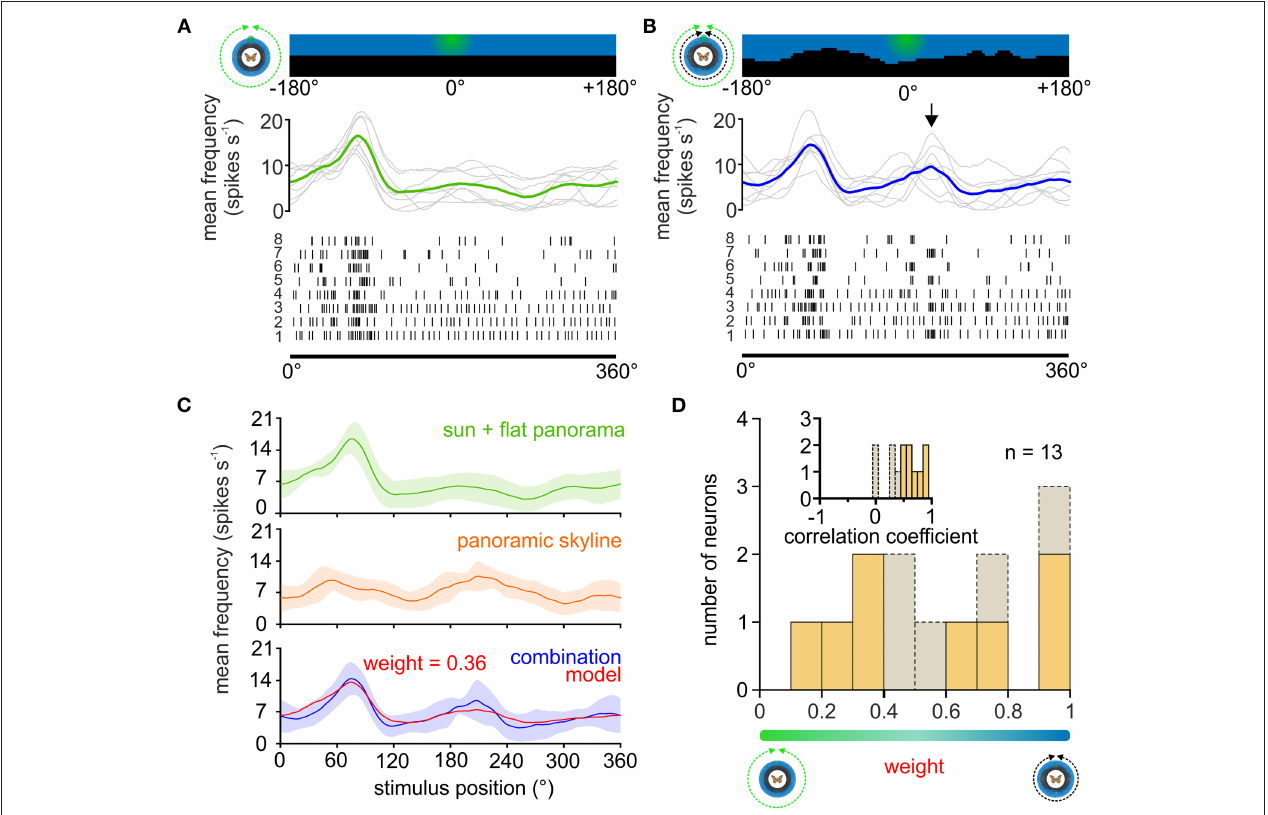
FIGURE 4 | Weighting the sun and panoramic skyline in TL neurons. (A,B) The response of a TL neuron to eight 360 ◦ -rotations of the sun stimulus (A) , and when the sun stimulus and the panoramic scene were rotated simultaneously around the animal (B) . The stimulus position prior to rotation is shown (top). The action potentials are shown as raster plots (bottom). Above the raster plots, the sliding window averages of the rotations are shown (middle plot, gray curves). The sliding window averages of the mean spiking frequency are color coded [ (A) , moving sun stimulus in green; (B) moving sun stimulus and panorama in blue]. Arrow indicates an increased spiking activity that was not observed when presenting the sun stimulus alone and thus can be attributed to the panoramic skyline. (C) Sliding window averages of the same TL neuron as in (A,B) responding to a 360 ◦ rotation of different stimuli. From top to bottom: sun stimulus alone (green curve), panoramic skyline alone (orange curve), sun stimulus and panoramic skyline combined (blue curve). A weighted linear model (red curve, lower plot) was fitted to the observed neural activity to the combined stimulus. Shaded areas show the standard deviation. (D) The distribution of the weighting factors for experiments with the sun stimulus and panoramic skyline ( n = 13). Low and high weighting values indicate that the sun stimulus and the panorama dominated the combined response, respectively. The correlation coefficient distribution in the inset indicates how well the weighted linear model described the measured neural response to the combined stimulus. Weighting factors obtained from a low correlation coefficient ( < 0.5), indicating that the neural response can be explained poorly with a linear model, are shown in